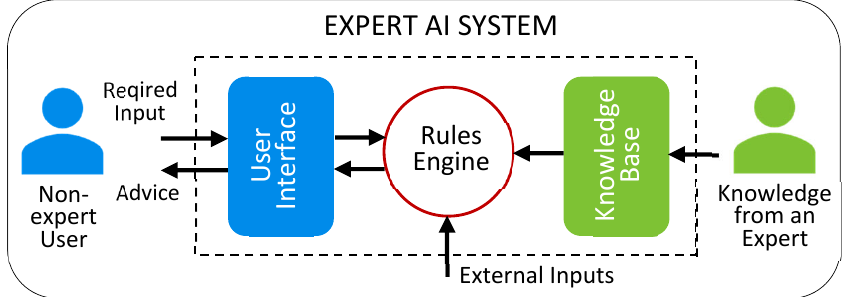
Figure 7. The flowchart of the expert artificial intelligence system.